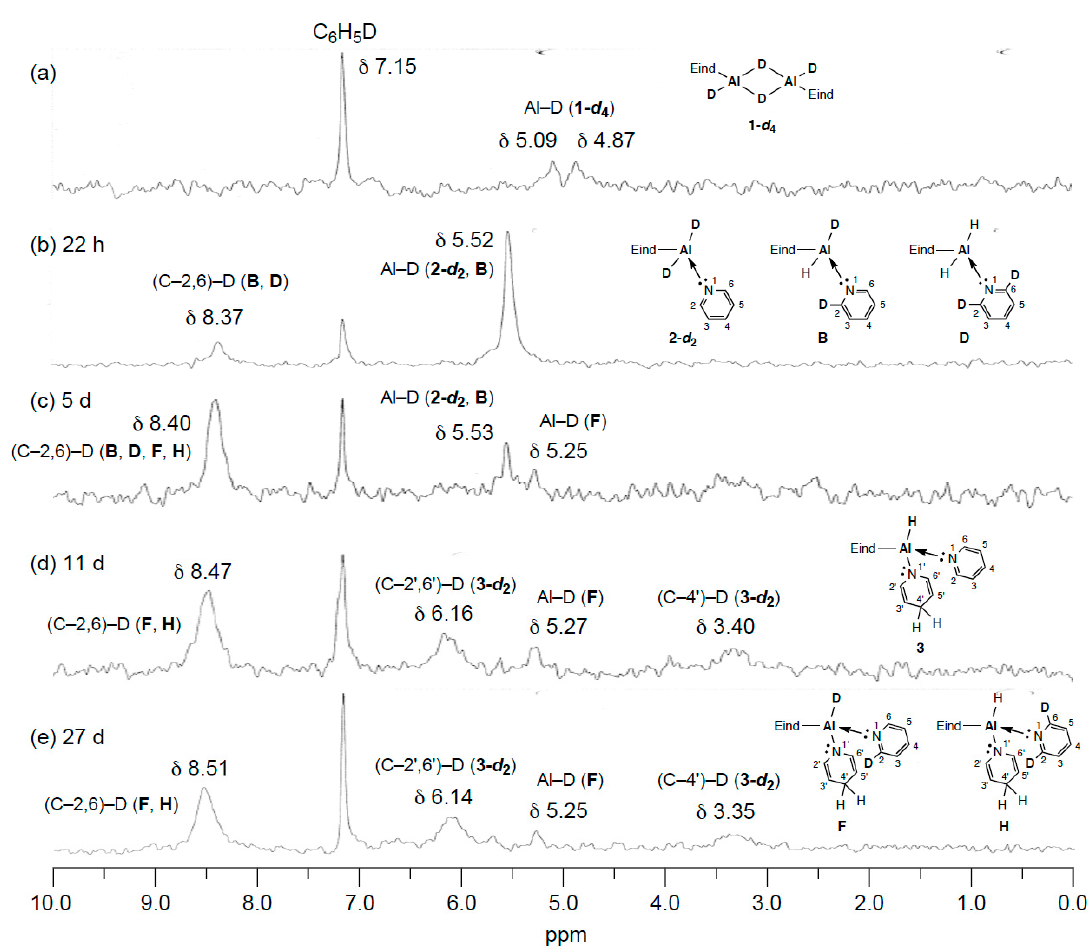
Figure 3. ( a ) 2 H NMR spectrum of 1- d 4 in C 6 H 6 at room temperature, and 2 H NMR spectra of the reaction mixture of 1- d 4 and Py in C 6 H 6 at room temperature; ( b ) after 22 h, ( c ) after 5 days, ( d ) after 11 days, and ( e ) after 27 days.